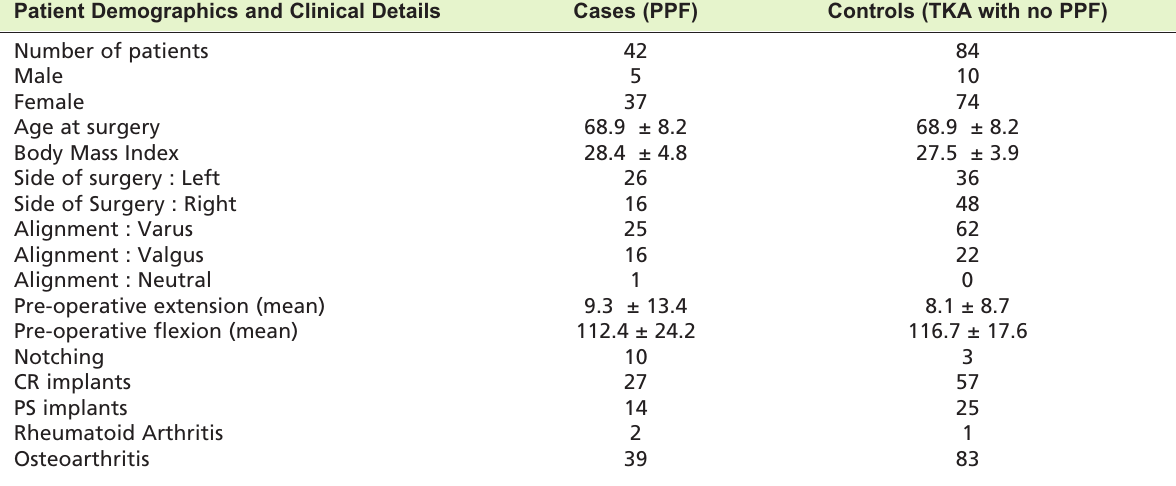
Patient demographics and clinical details Table I: